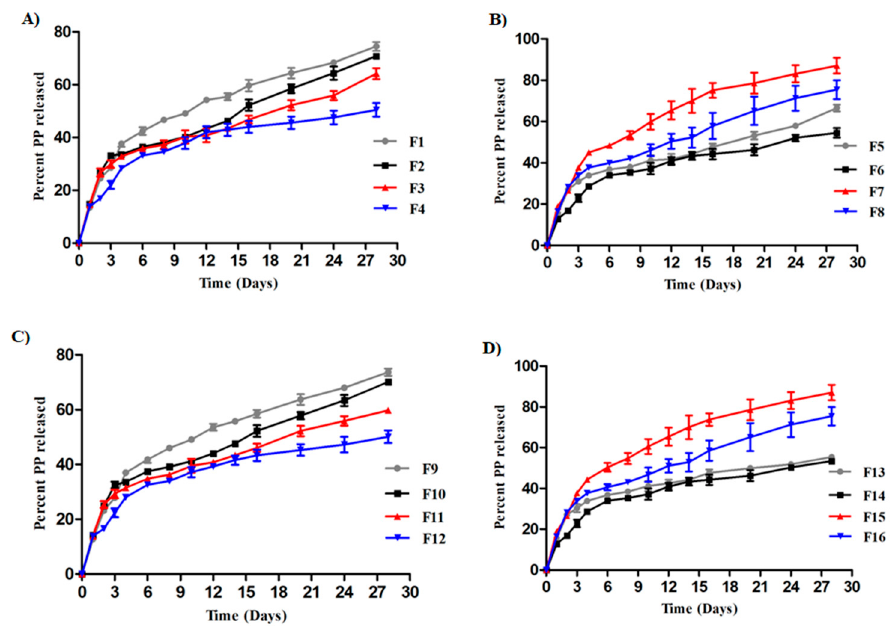
Figure 2. In vitro release profiles of PP from ( A ) F1–F4, ( B ) F5–F8, ( C ) F9–F12, and ( D ) F13–F16 (mean values ± SD, n = 3).